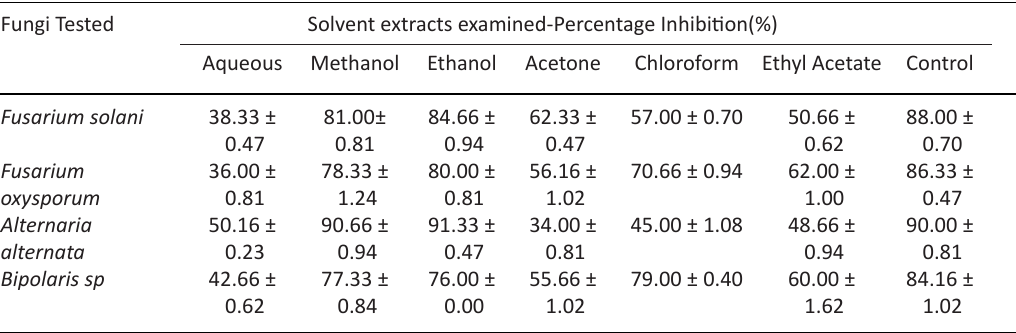
Table 2. Inhibitory Activity of Laurus nobilis Solvent Extracts Against Fungal strains. Fungi